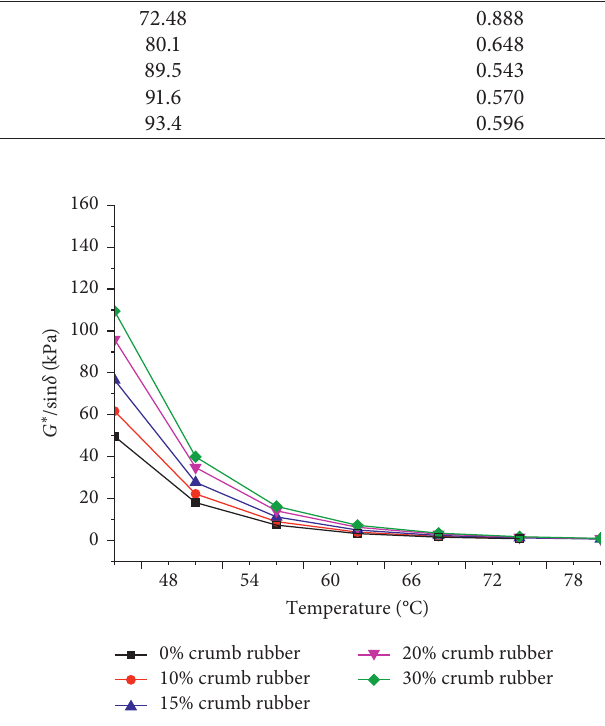
Figure 2: Rutting factor G ∗ /sin δ with different temperatures.